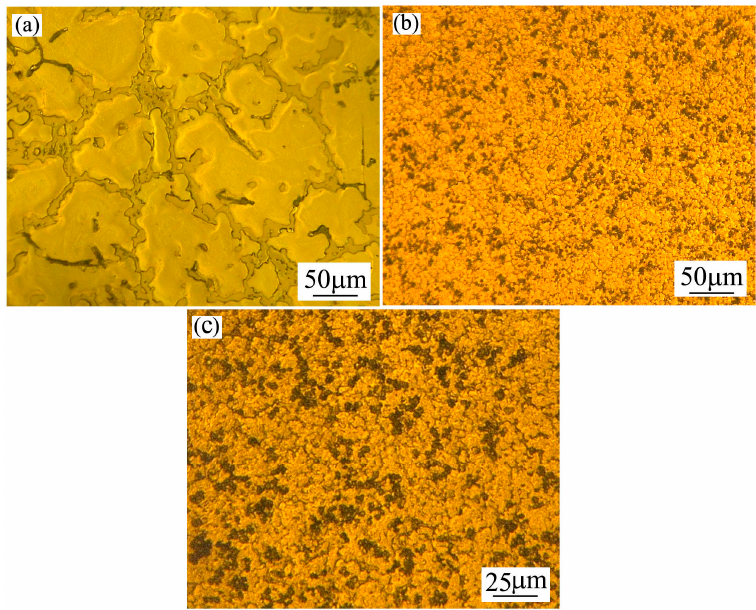
Figure 1. Optical microstructures of AZ91D+0.75Ce alloy fabricated by different methods: ( a ) As-cast; ( b ) spray-casting with low magnification and ( c ) spray-casting with high magnification.